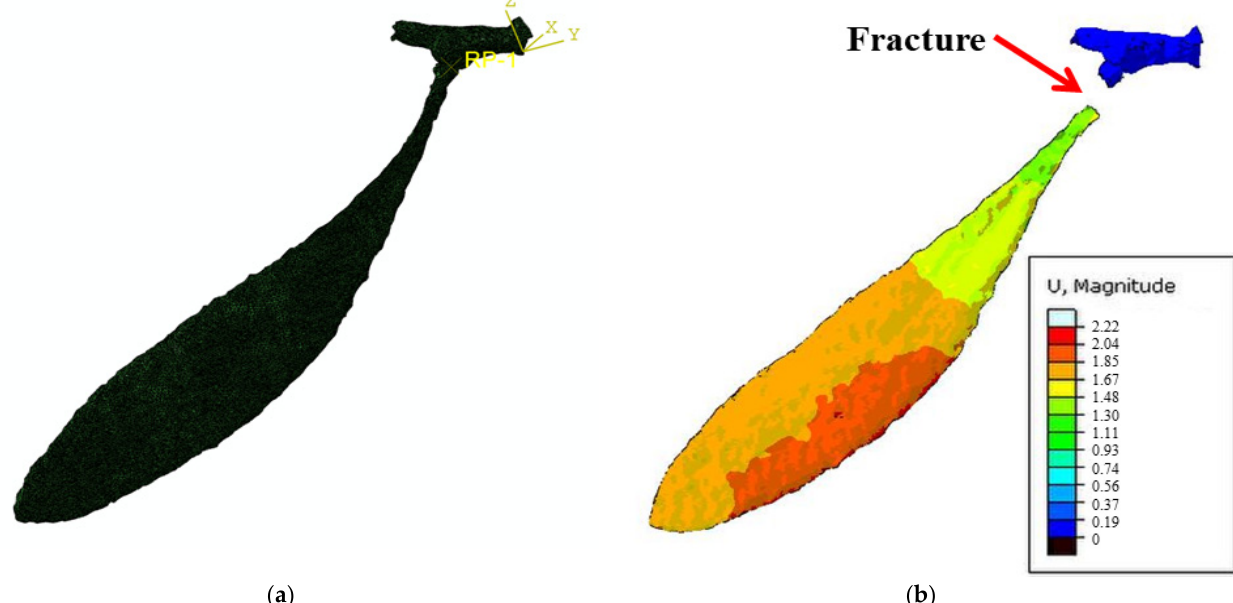
Figure 6. The meshed model ( a ) and the result ( b ) of the leaf in the detachment simulation.